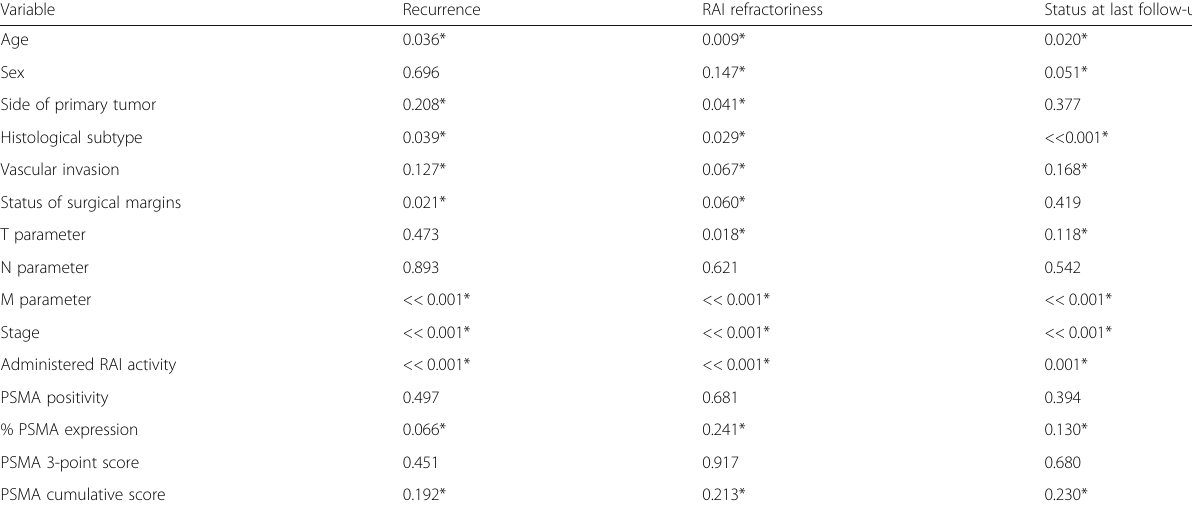
Table 4 Results ( p values) of univariate analysis in respect of outcomes Variable